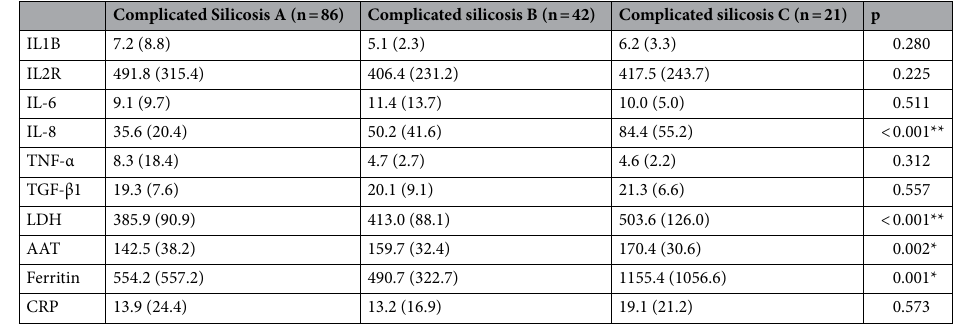
Table 4. Serum levels of biomarkers in the group of complicated silicosis A, B and C. IL1β Interleukin 1 beta, IL2R interleukin 2 receptor subunit alpha, IL-6 Interleukin 6, IL-8 interleukin 8, TNF-α Tumour necrosis factor alpha, TGF-β1 Transforming growth factor-beta 1, AAT alpha-1 antitrypsin, LDH lactate dehydrogenase, CRP C-reactive protein. Statistical significance was determined using χ 2 test and ANOVA test for qualitative and continuous variables, respectively. *p < 0.05; **p < 0.001.